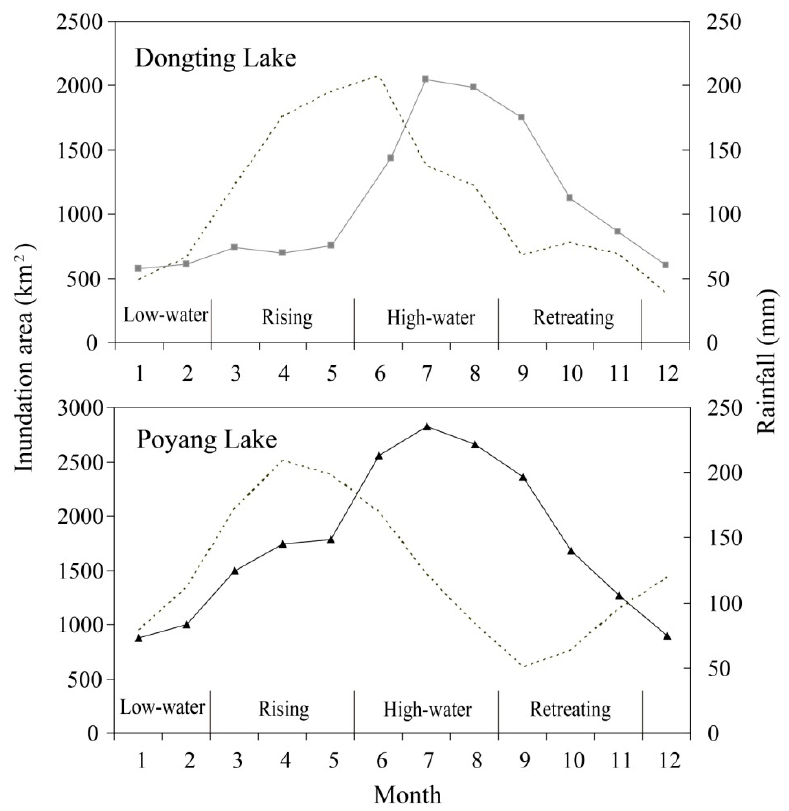
Figure 4. Mean monthly inundations in the two lakes over the period of satellite observations ( solid line ). The monthly means of the inundation areas were calculated from the data in Figure 4. The right Y-axis indicates the monthly rainfall within each lake ( dotted line ).